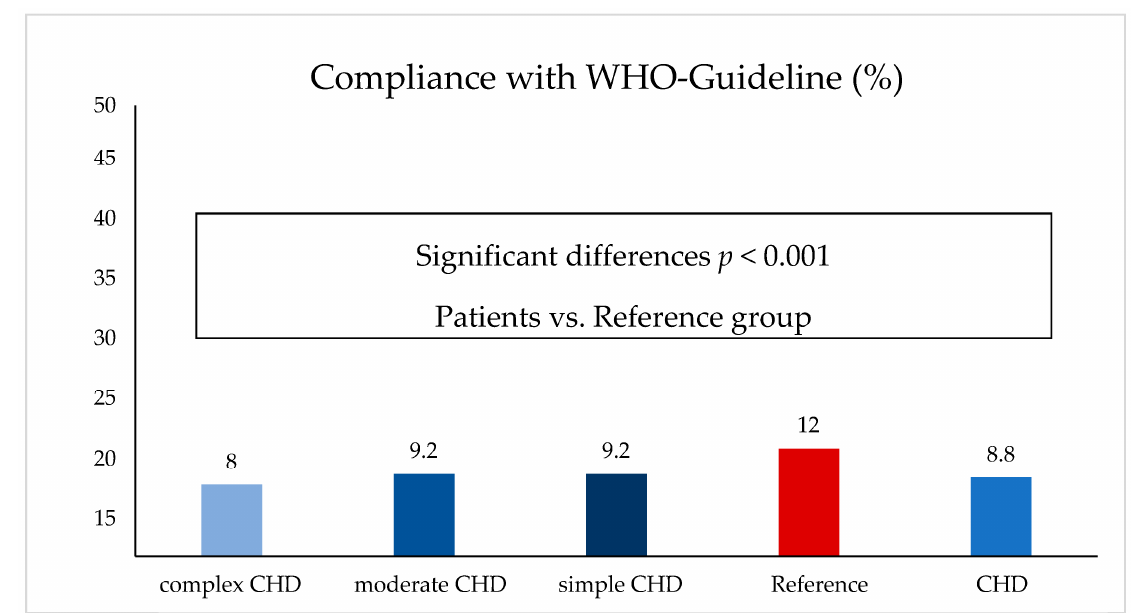
Figure 2. Compliance with WHO guidelines (patients vs. reference). Figure 2 modified according to Jahn, Annika (2022): Körperliche Aktivität und